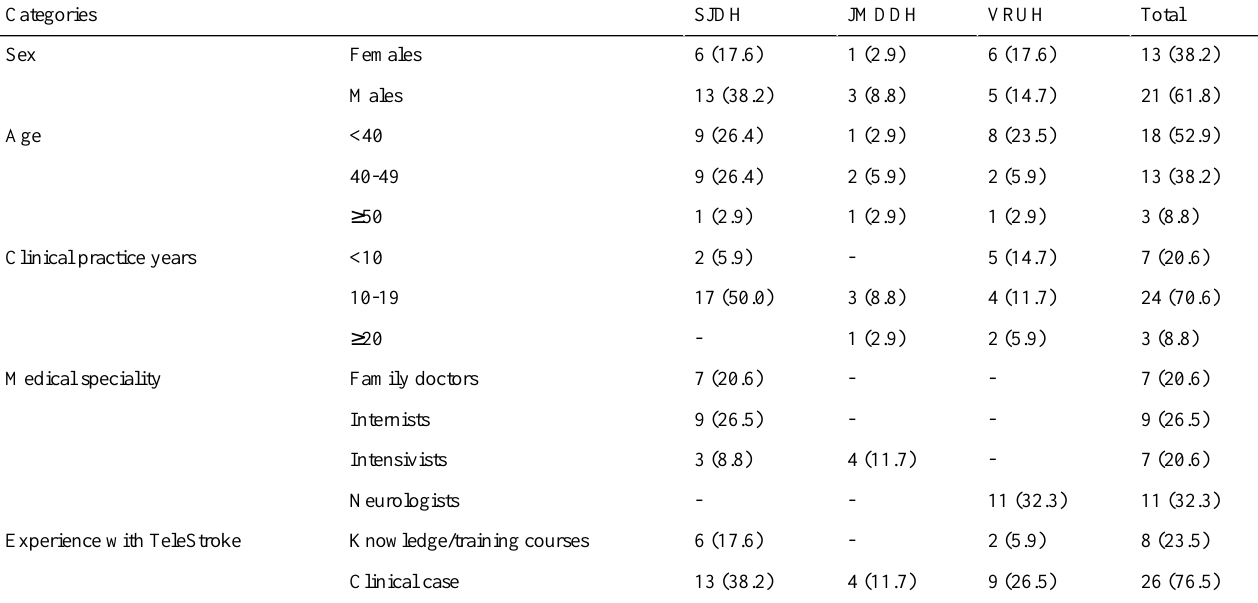
Table 4. Characteristics of medical professionals who have used TeleStroke; data are presented as n